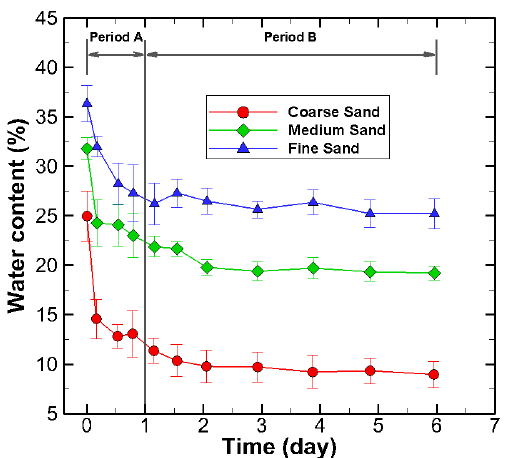
Figure 3. Temporal changes of the measured water contents (symbols and bars represent mean and standard deviation of the water contents, respectively).